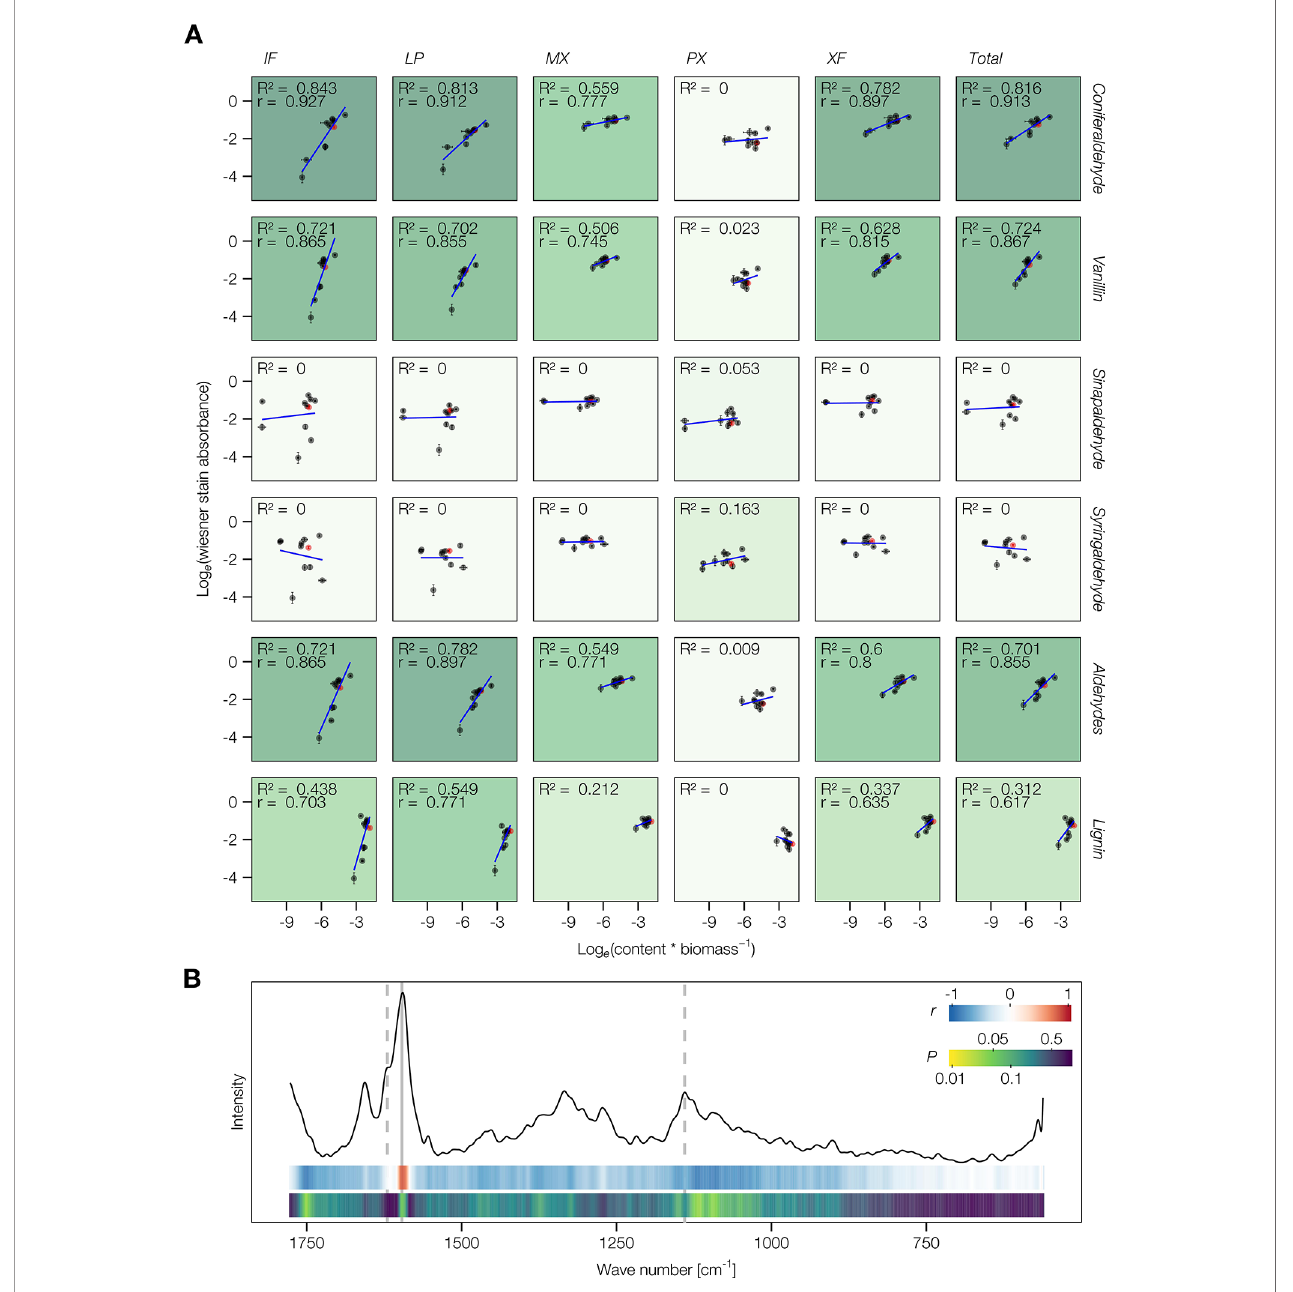
FIGURE 4 | Quantitative aspect of the Wiesner test on lignin or its monomers. (A) Correlation analysis between the absorbance of different cell types stained by the Wiesner test and the relative content of lignin aldehydes, G or S C 6 C 3 or C 6 C 1 measured by pyrolysis/GC – MS. ‘ Total' refers to the average across cell types weighted according to their proportional area contribution. Wild type (WT) is indicated in red. The explained variance ( R 2 ) is indicated by the intensity of the green background and the Pearson correlation coef fi cient r is shown where its P < 0.05. (B) Comparisonbetween the absorbance of cells stained by the Wiesner test and the microspectra obtained using Raman confocal microspectroscopy for IF, MX, and XF in WT and 4cl1 x 4cl2 mutant plants. Representative Raman microspectra of a WT metaxylem vessel cell wall is presented together with color coded ribbons showing the strength and P -value of the Pearson correlation between Ramanintensity and Wiesner test absorbance for each wave